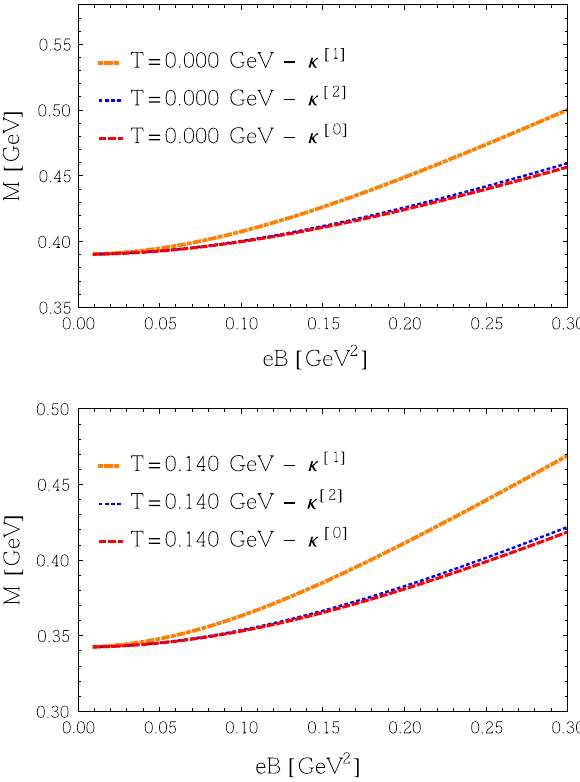
Fig. 7 Effective quark mass as function of the magnetic field for T = 0 . 05 GeV (top panel) and T = 0 . 140 GeV (low panel) with fixed values of κ